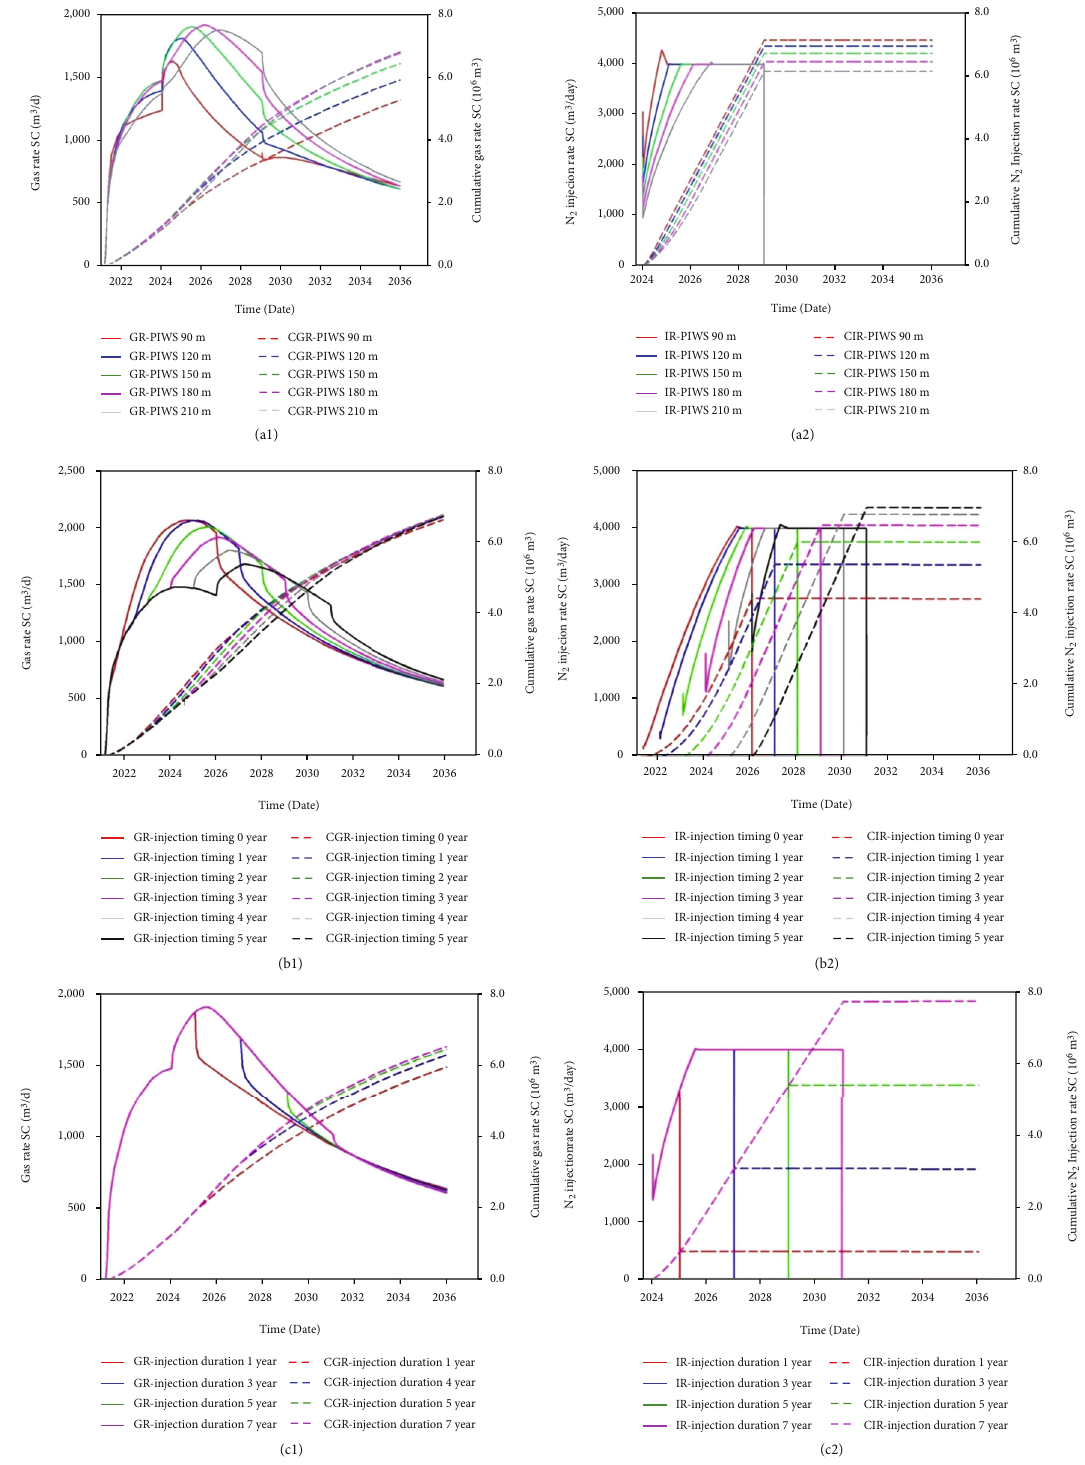
Figure 4: CBM production curves and N injection curves under di ff erent N injection production conditions: (a, c, and e) are CBM 2 2 production curves of production injection well spacing, gas injection timing, and gas injection duration, respectively; (b, d, and f) are the injection curves of production injection well spacing, gas injection timing, and gas injection duration, respectively. PIWS stands for N 2 production injection well spacing, GR denotes daily gas production, CGR represents cumulative gas production, IR denotes daily gas injection, and CIR denotes cumulative gas injection. SC refers to surface